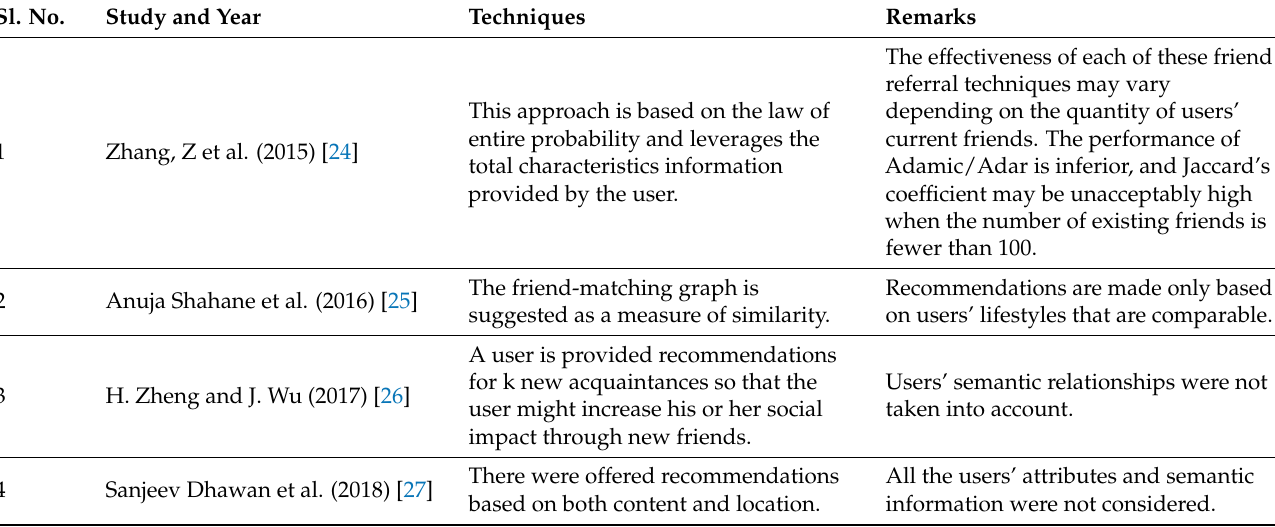
Table 1. Comprehensive survey of recommendation